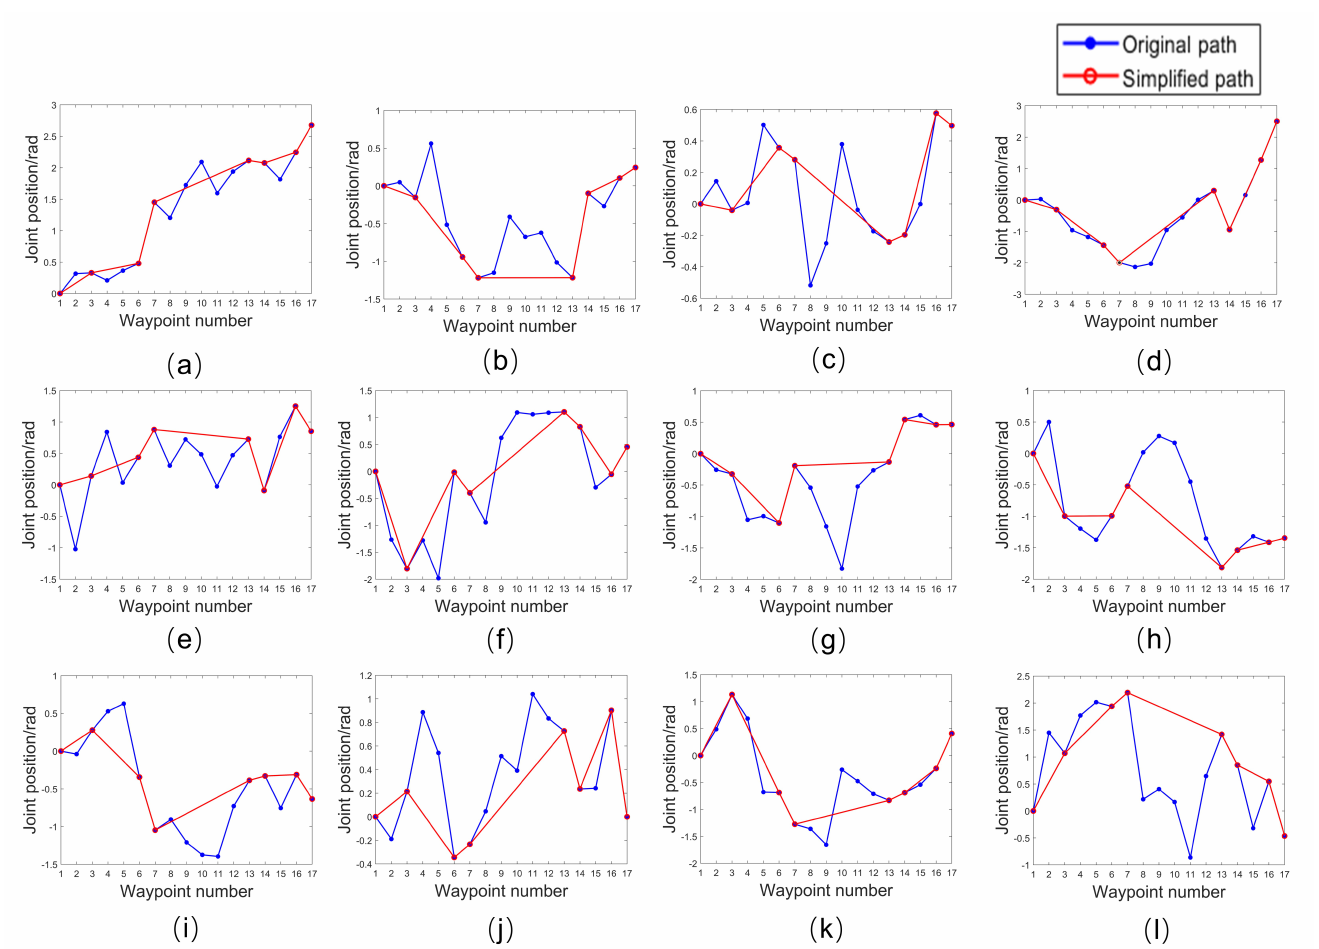
Figure 8. Comparison of original path and simplified path of each joint. ( a – f ) Positions of the left robot joint 1–6. ( g – l ) Positions of the right robot joint